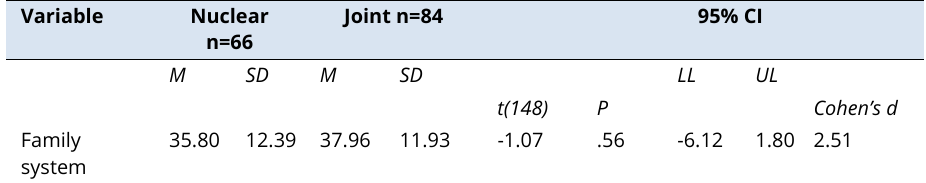
Table 5. Independent Samples t-test to Determined Family System Differences (N=150) Variable